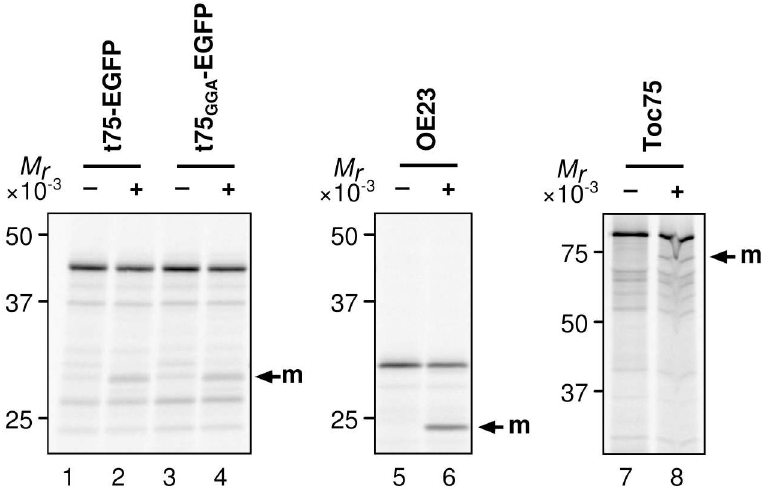
Fig 6. Processing of t75-EGFP variants by Plsp1 in vitro . Radiolabeled proteins indicatedat top were incubatedwithout or with recombinant Plsp1 protein for 2 h at room temperature, separatedby SDS-PAGE, and detected by